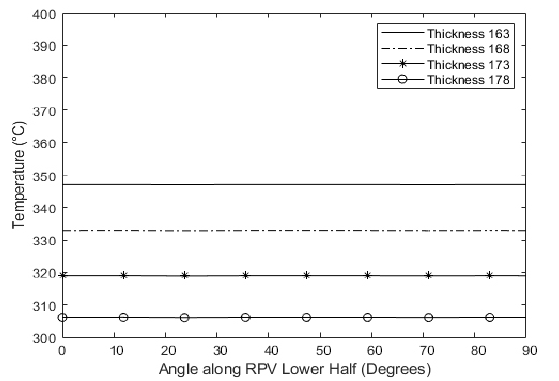
Fig. 9: External temperature variation by changing thickness of RPV lower plenum for constant